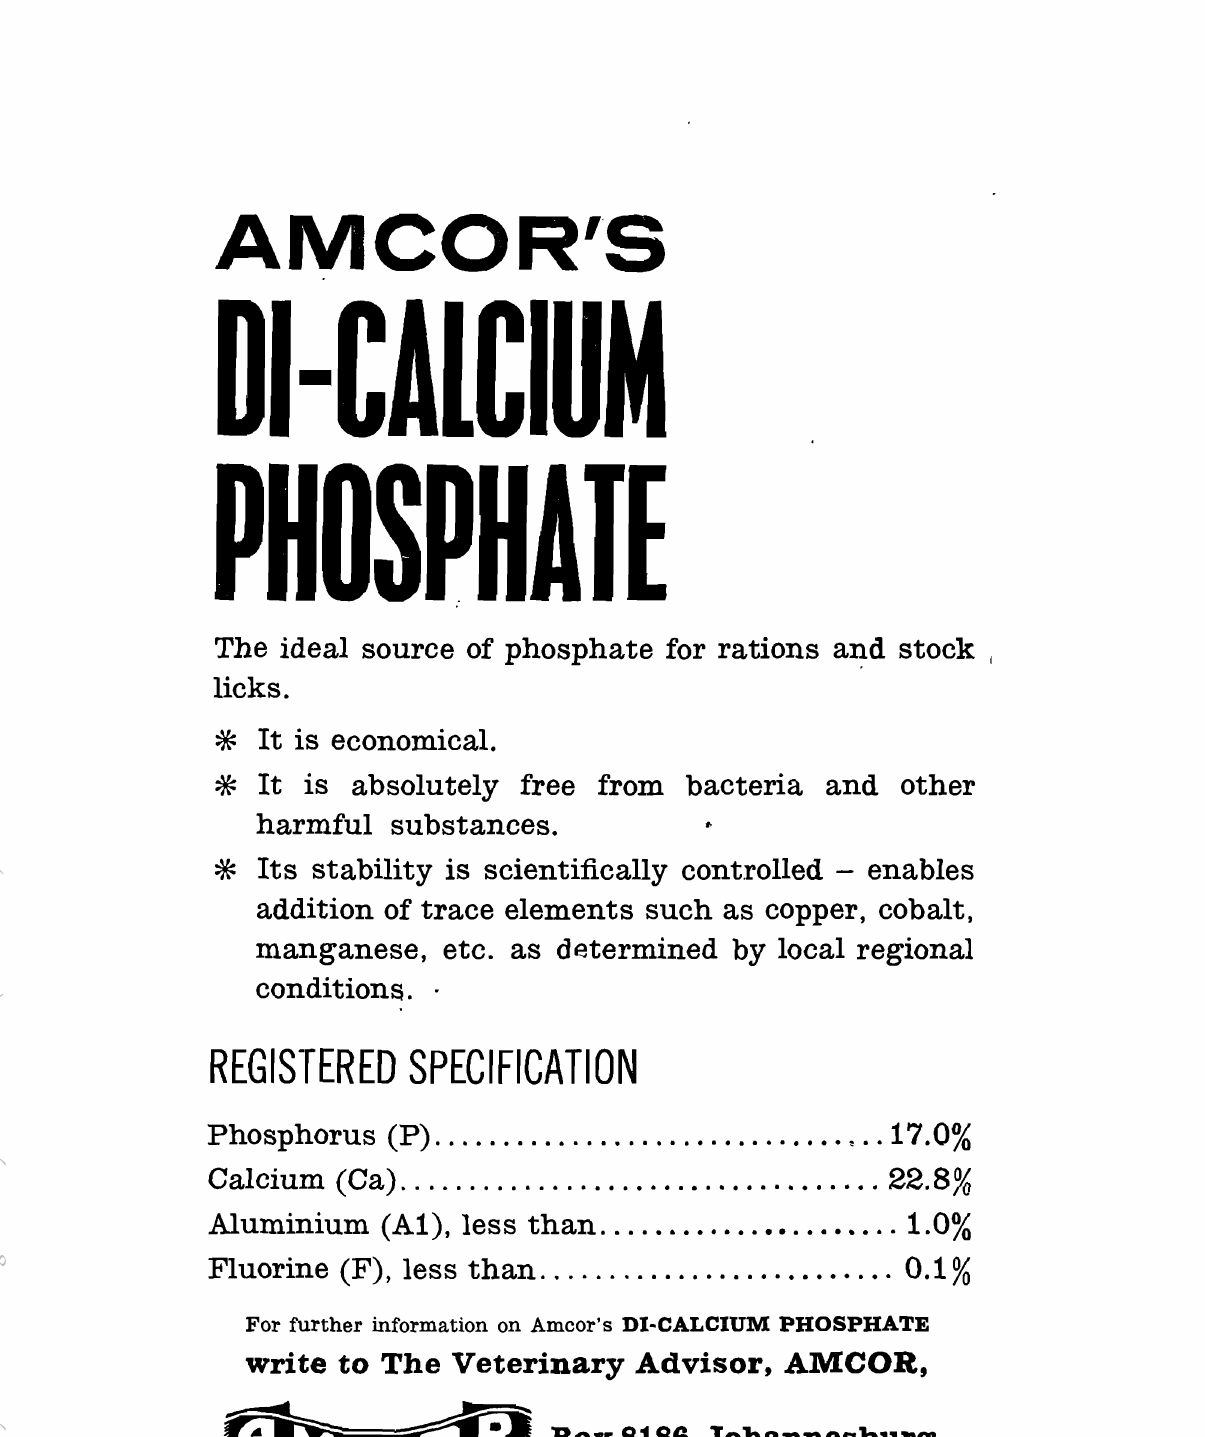
The ideal source of phosphate for rations a~d stock